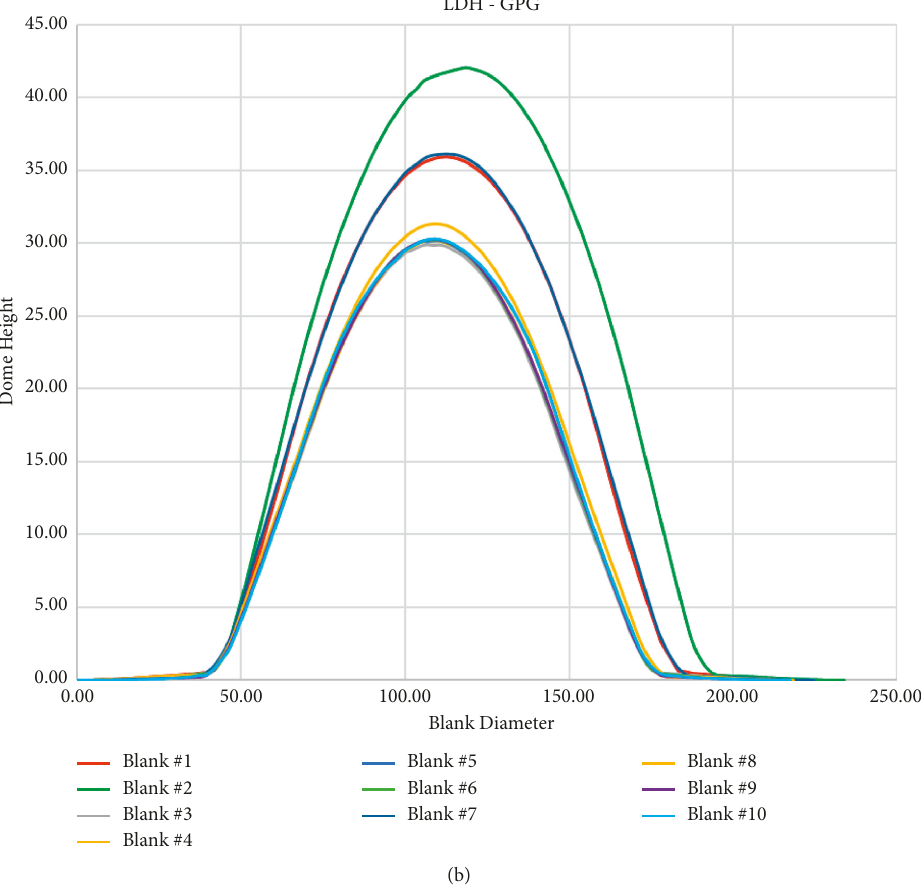
Figure 10: Dome height vs process parameters comparison: (a) APA and (b)